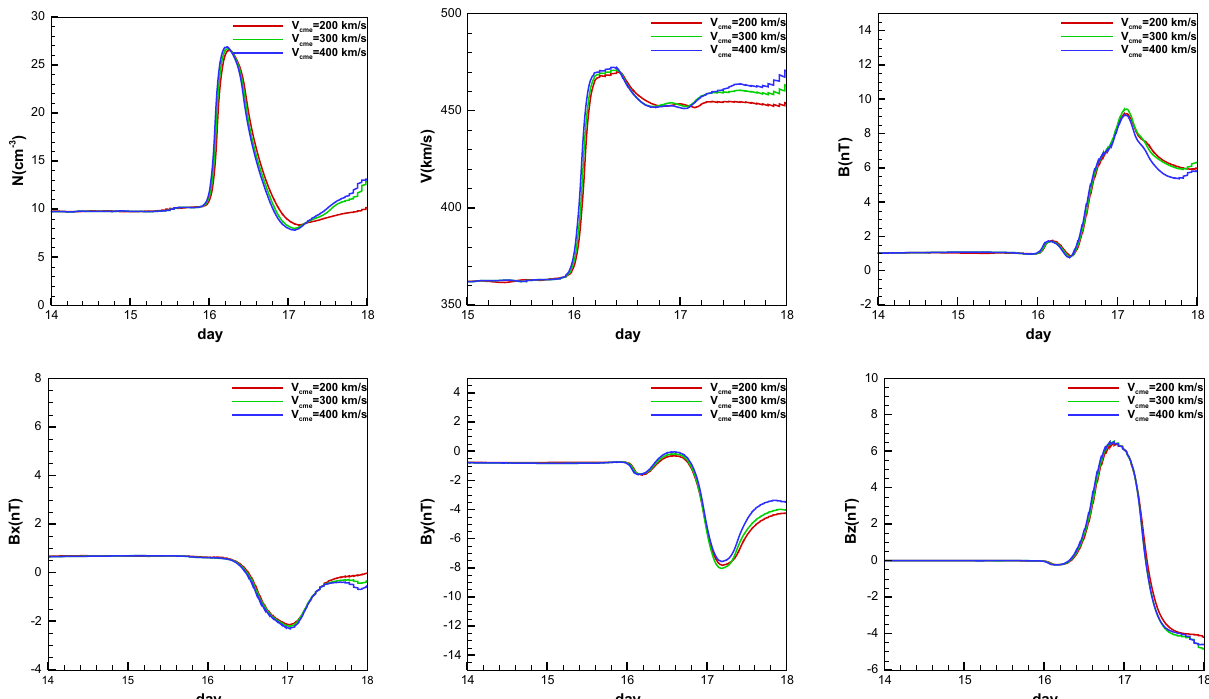
Fig. 14. Evolution of solar wind parameters at the Earth with different velocities in the CME. The fi rst row present the number density (left), fl ow velocity (middle), magnetic fi eld (right), and the second row are the three components of magnetic fi eld ( B